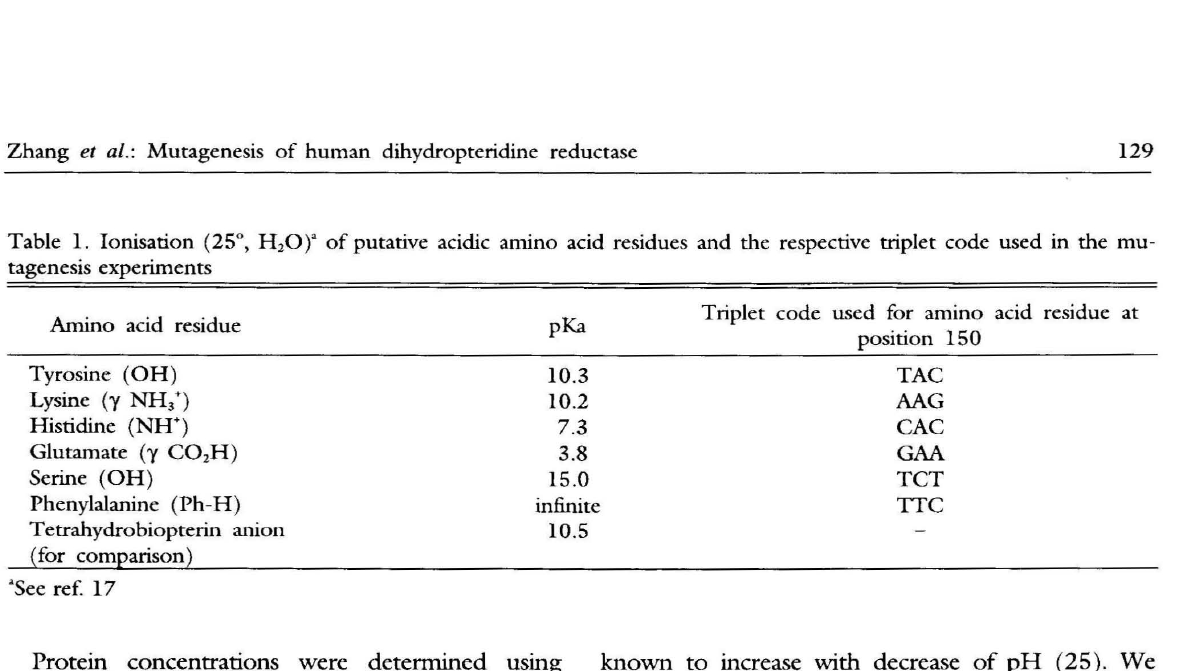
Table 1. Ionisation (25°, H 0), of putative acidic amino acid residues and the respective triplet code used in the mu 2 tagenesis